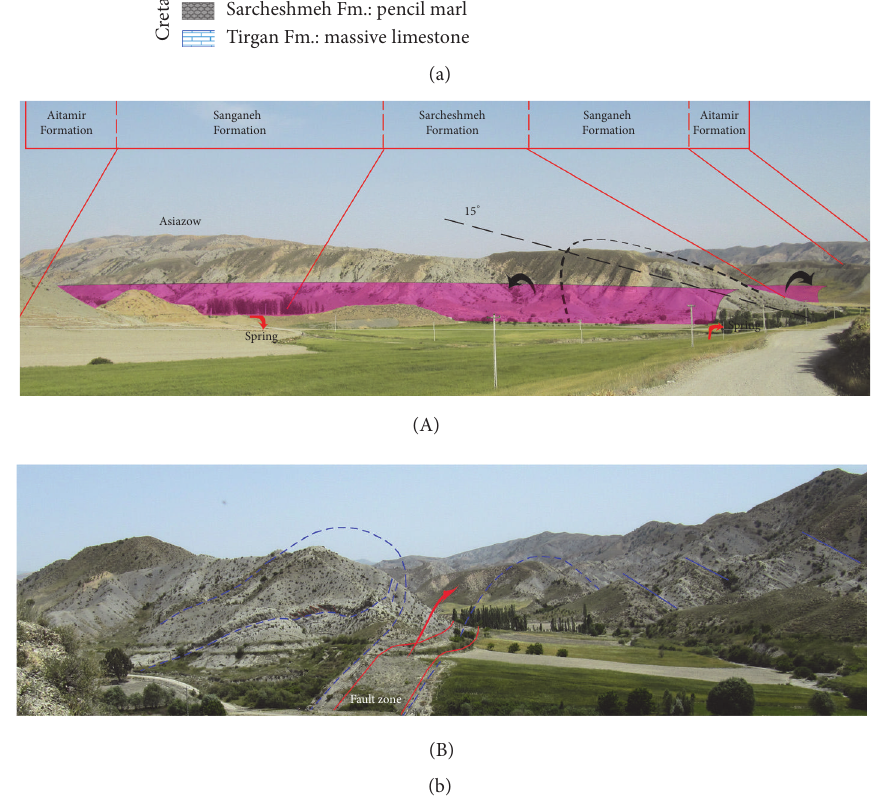
Figure 2: (a) Sampling locations and the geological map of the study area and (b) the simulated photographs of (A) Kuh-e-Asiazow anticline; the fold axis with E-W trend has ∼ 15 ∘ plunge to the west. The thrust plane is shown as pink sheets; the view is to the southeast, and (B) a fold-thrust fault in Sanganeh shale and marl, view is to the east